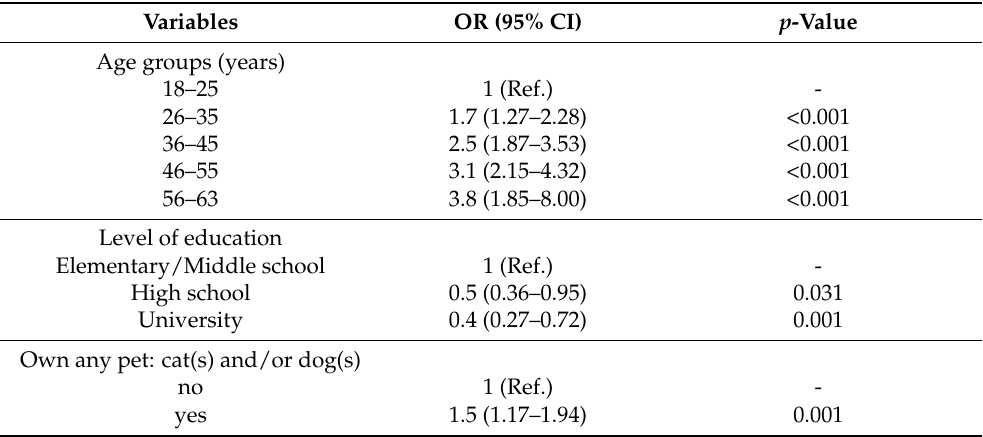
Table 4. Risk factors for Toxoplasma gondii infection in multiple logistic regression. Variables OR (95% CI) p